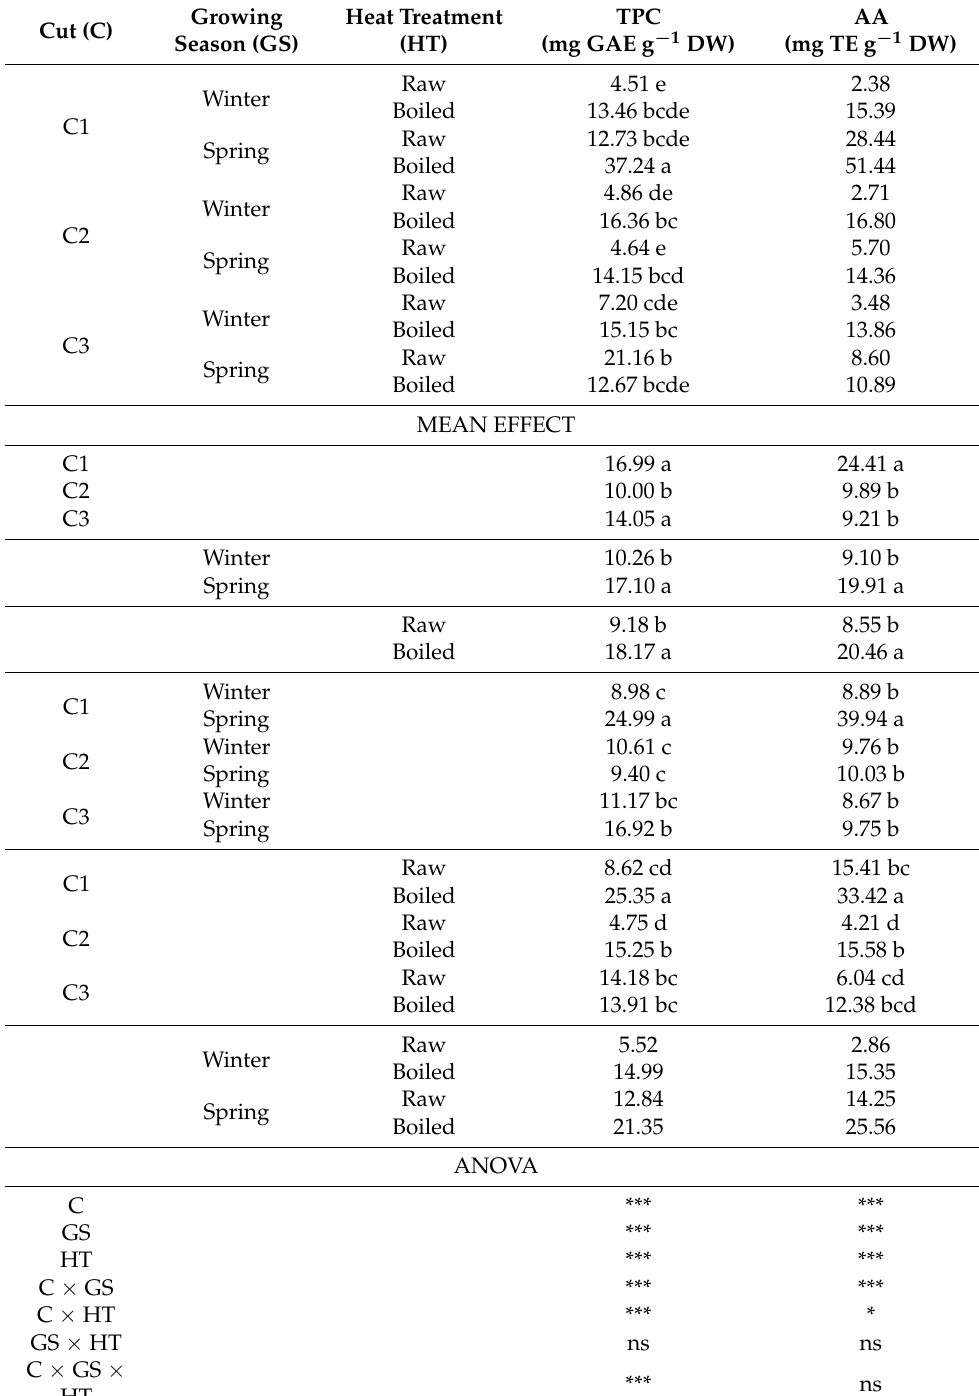
Table 4. Total phenolic content (TPC) and antioxidant capacity (AA) in raw or boiled leaves of Plantago coronopus hydroponically grown under greenhouse in winter or in spring and subjected to three consecutive cuts (C1, C2, C3). Data keyed with different letters are significantly different for p < 0.05 following three-way ANOVA and Tukey’s HSD post-hoc test for the effect of growing season, cut and boiling.